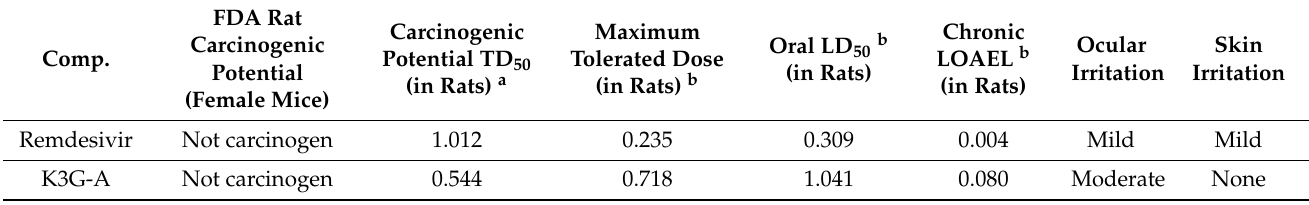
Table 5. Toxicity properties for K3G-A and remdesivir.